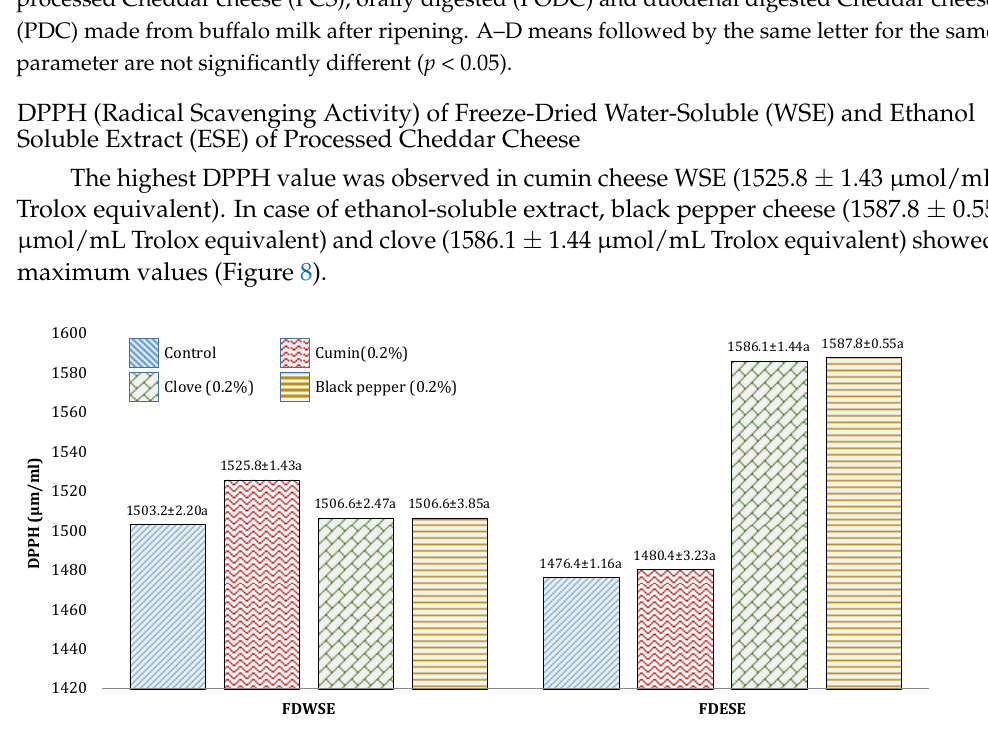
Figure 8. Mean values for DPPH (Radical Scavenging Activity) (µmol/mL Trolox equivalent) of freeze-dried water-soluble and ethanol-soluble extract of processed Cheddar cheese made from buffalo milk after ripening. a means followed by the same letter for each type of processed Cheddar cheese are not significantly different ( p <